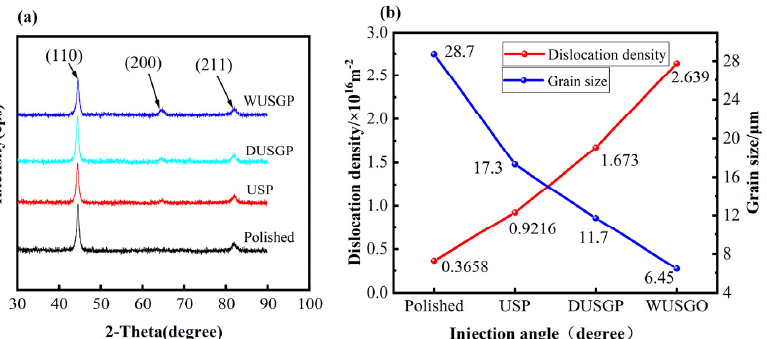
Figure 5. ( a ) The X ‐ ray diffraction pattern characteristics on sample surface; ( b ) dislocation density and grain size of samples.